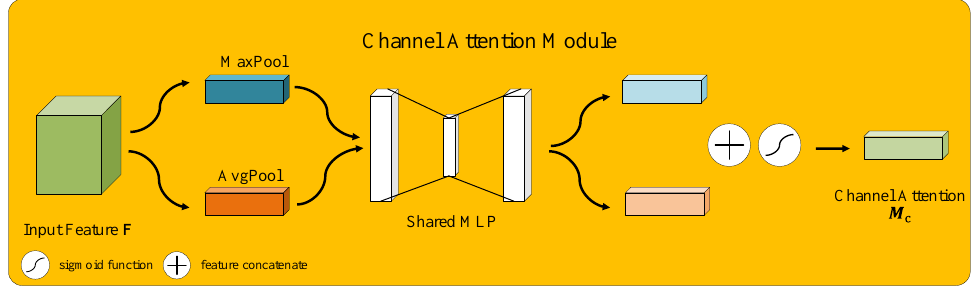
Figure 3. Channel Attention Module.